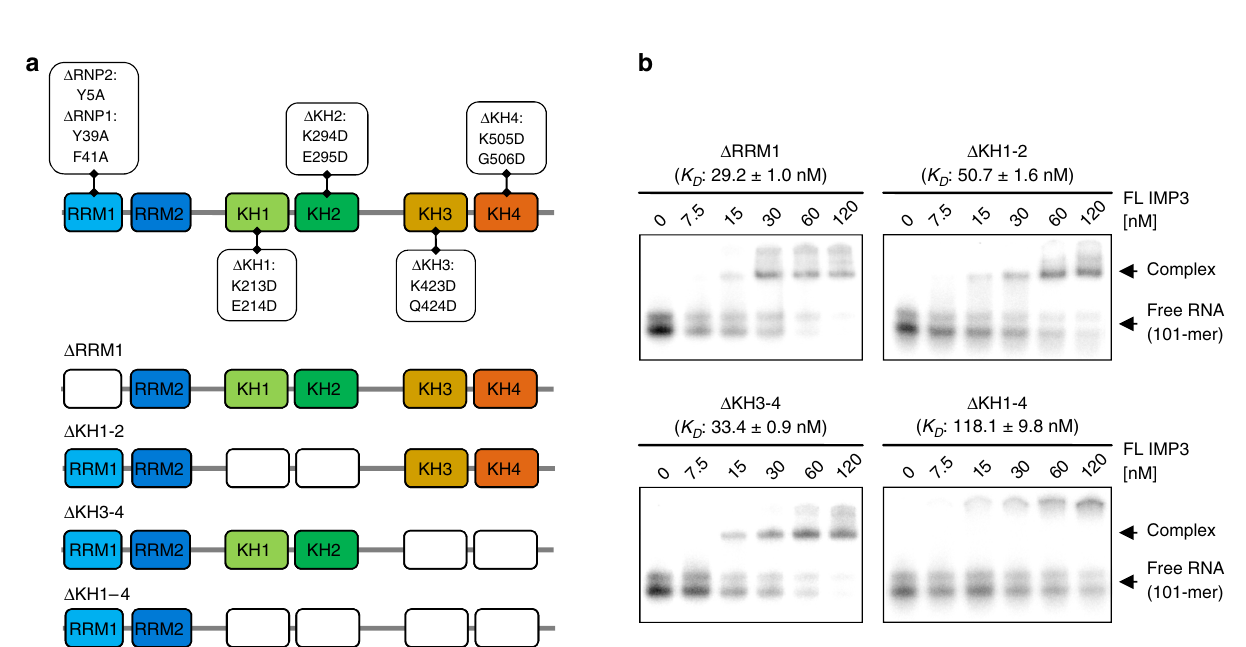
Fig. 5 RNA recognition mode of the IMP3 RRM1 – 2 tandem domain. a IMP3 RRM1 – 2 function as tandem in solution. Secondary structure elements in the RRM1 – 2 tandem domain as obtained from secondary chemical shifts are shown on top. { 1 H} – 15 N heteronuclear NOE values show that the linker connecting the two globular domains is rigid. Tumbling correlation-time values ( τ C , bottom), derived from NMR relaxation data (Supplementary Fig. 8), show an average value of 11.7 ns, indicating that both domains tumble together in solution. Gaps indicate prolines or residues with missing data. Error bars derived from error propagation using T 1 and T 2 values in Supplementary Fig. 8. b Pairwise distance distribution, P( r ), for IMP3 RRM1 – 2 at 1 mg/ml derived from SAXS data (Supplementary Fig. 8). The maximum pairwise distance ( D max ), radius of gyration ( R g ), and the Porod volume ( V Porod ) are consistent with a monomeric RRM1 – 2 tandem domain particle in solution. c Overlay of 1 H, 15 N NMR correlation spectra of RRM1 – 2 alone and in the presence of different concentrations of (CA) 5 RNA (see color code). The inset shows representative residues affected by RNA binding. d Chemical shift perturbations (CSP) observed (see panel c ) at the endpoint of the titration. The two domains and their RNP sequence motifs are labeled on top. The dotted lines indicate CSP thresholds calculated as average (gray) plus one and two standard deviations (pink and violet, respectively). The lower panel shows CSP from an NMR titration with (GU) 5 RNA (Supplementary Fig. 8). e RNP sequence motifs in the RRM1 and RRM2 subdomains. f Mapping of CSPs for the titration with the (CA) 5 RNA ( d ) onto a structural model of RRM1 – 2 (see the Results and Methods sections). Amides are shown as spheres colored according to thresholds in ( d ). g ITC data for the titration of RRM1 – 2 with (CA) 5 or (GU) 5 RNAs. A titration of (CA) 3 hexamer to RRM1 – 2 is shown in Supplementary Fig. 8. The suggested complex topology and K D values are indicated. Values represent mean and standard deviation of three experiments. All ITC measurements are